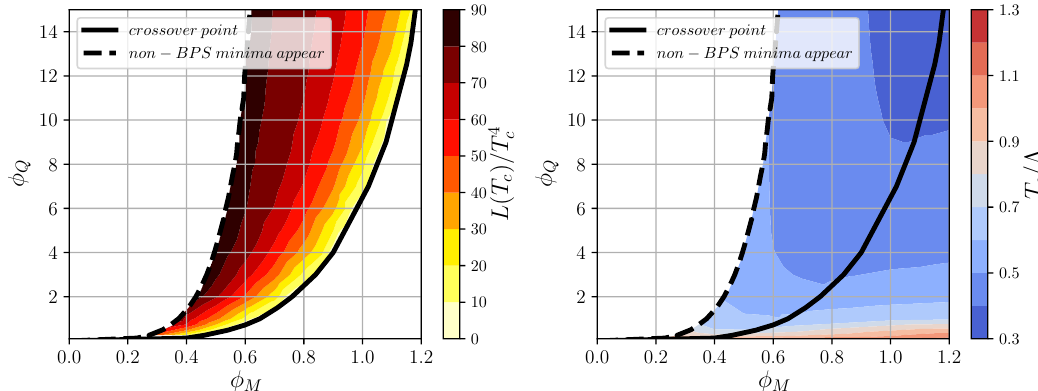
Figure 5 . Filled contours of latent heat L in units of the critical temperature T c for different values of the two scalar potential parameters on the left, and of the critical temperature T c in units of the coupling for different values of the scalar potential parameters on the right. The contours found past the crossover line on the critical temperature plot are from the peak of the interaction measure.